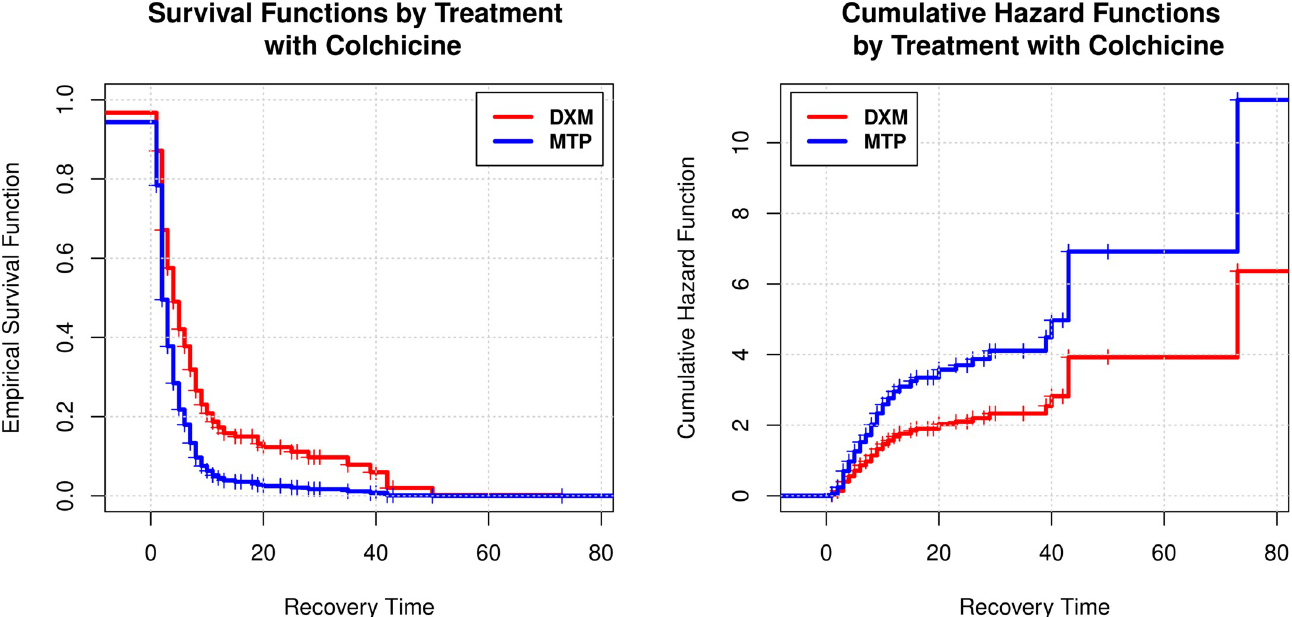
Fig 4. A . Survival function estimated by the Cox model, according to whether they received corticosteroid with colchicine. B. Cumulative hazard function estimated by the Cox model if the drug colchicine was added to the corticosteroid.